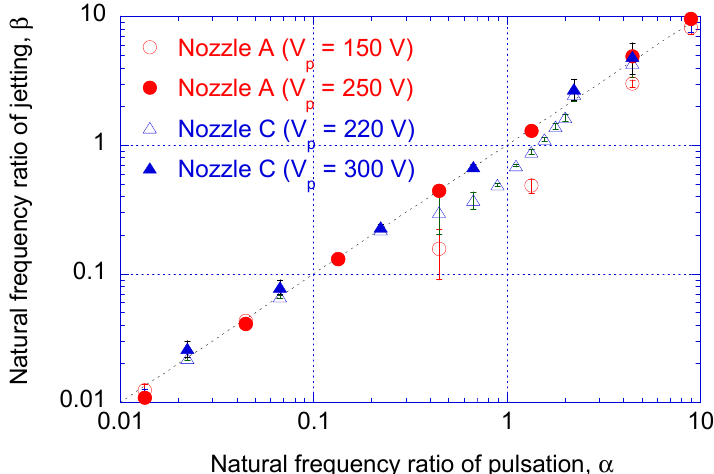
Figure 6. Natural frequency ratio of jetting as a function of natural frequency ratio of pulsation for overdamped nozzles A ( f c = 224 Hz) and C ( f c = 448 Hz). Pulse voltages of 150 V and 220 V are the minimum jetting voltages for nozzles A and C, respectively, while 250 V and 300 V are the increased pulse voltages of jetting for nozzles A and C, respectively.